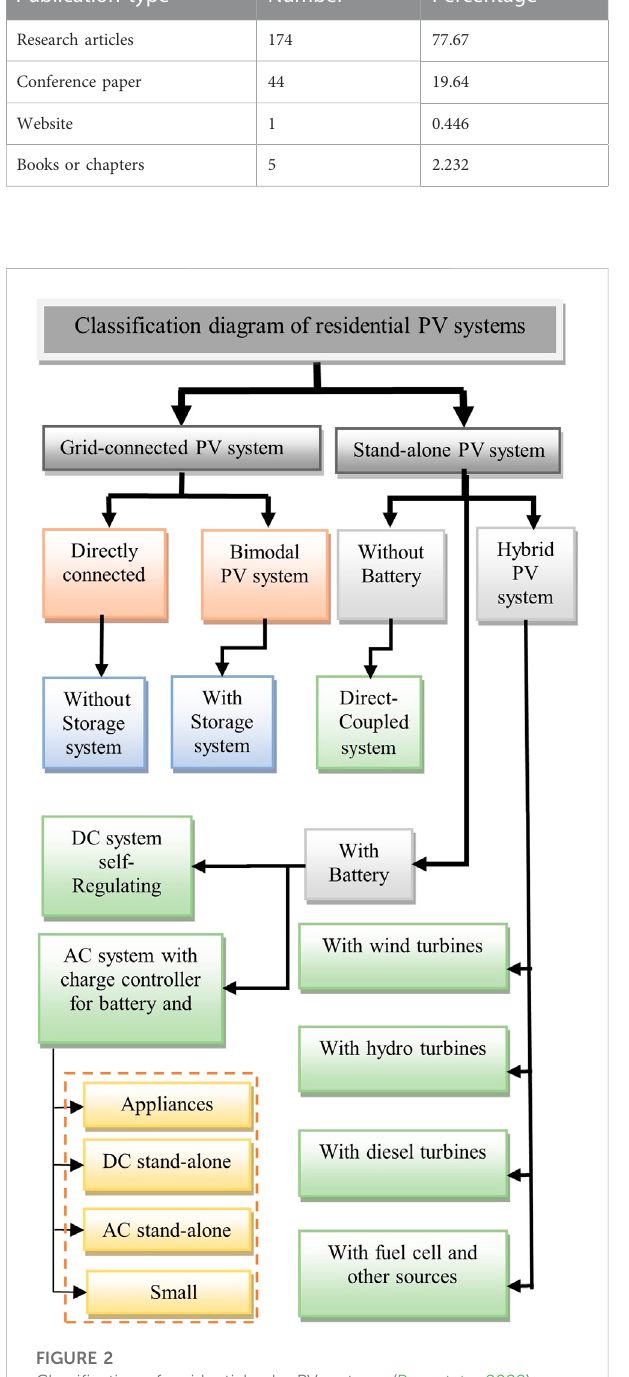
FIGURE 2 Classi fi cation of residential solar PV systems (Pennstate, 2022).